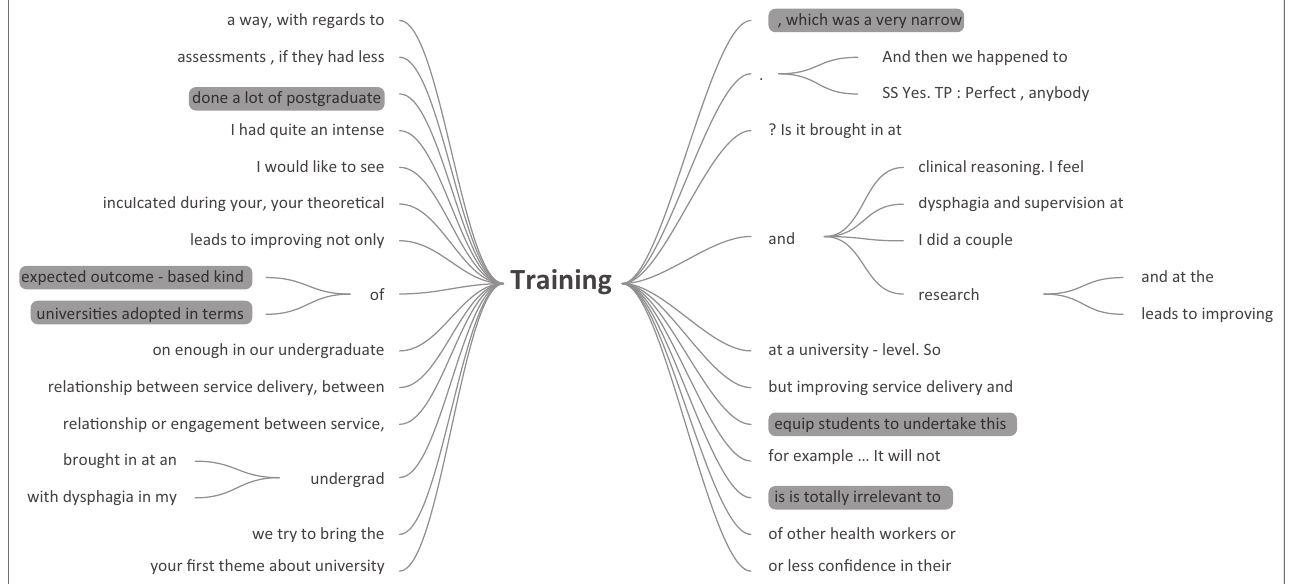
we try to bring the